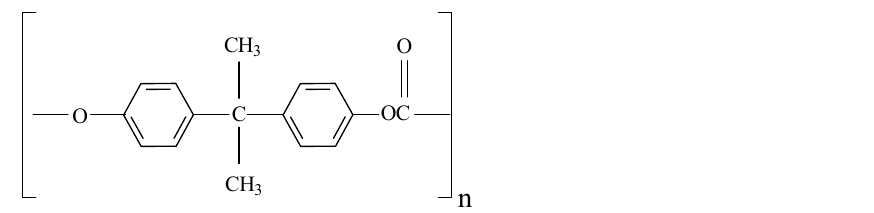
Figure 1. The formula chemical structure of the polycarbonate matrix 2.2 Thermal aging experi- ments.